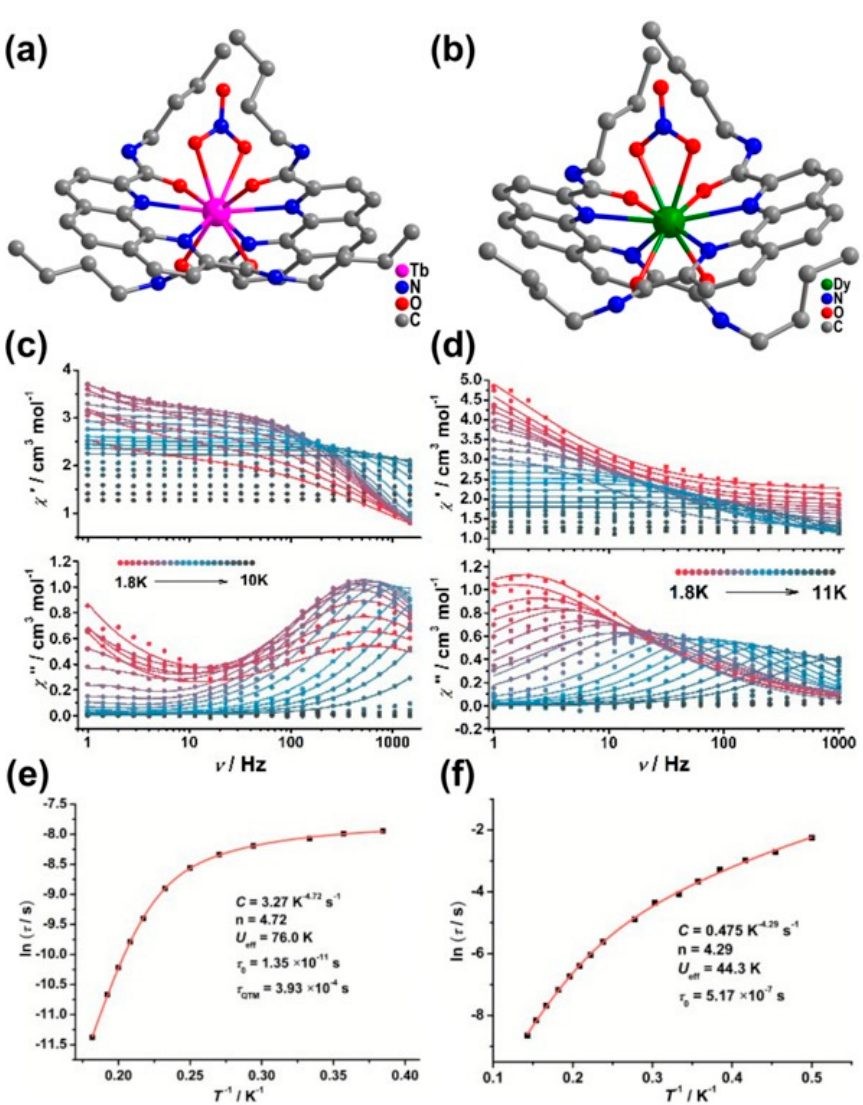
Figure 13. ( a , b ) Perspective viewings for the cationic structures of 24 and 25 , ( c , d ) frequency dependence of in-phase ( χ ′ ) and out-of-phase ( χ ″ ) AC magnetic susceptibility for 24 and 25 under a 1.5 kOe (for 24 ) and 1.0 kOe (for 25 ) DC field, and ( e , f ) the ln( τ ) vs. T − 1 plots for 24 and 25 (red lines are the best fits). Figures and captions are reproduced from Reference [48] with permission from the Royal Society of Chemistry.